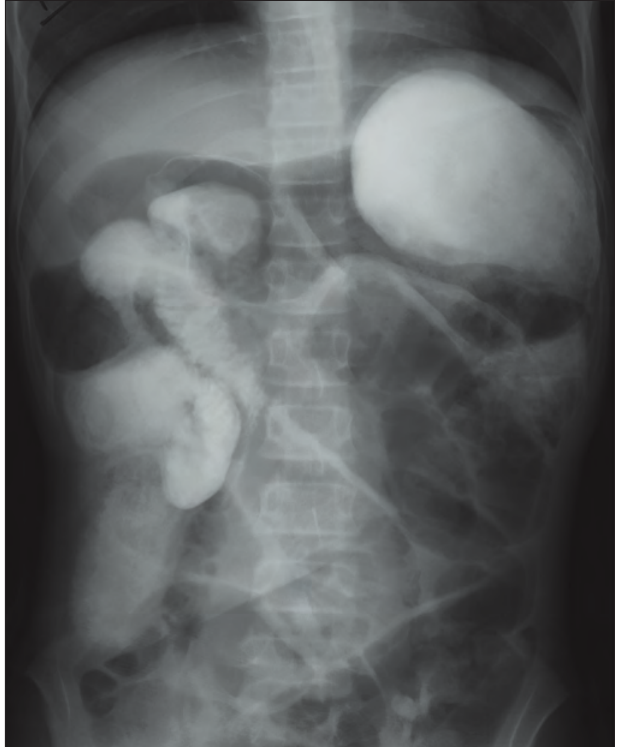
Fig. 3. Iodine contrast meal and follow-through (delayed images). A collection of small-bowel loops is noted in the right hypochondrium.